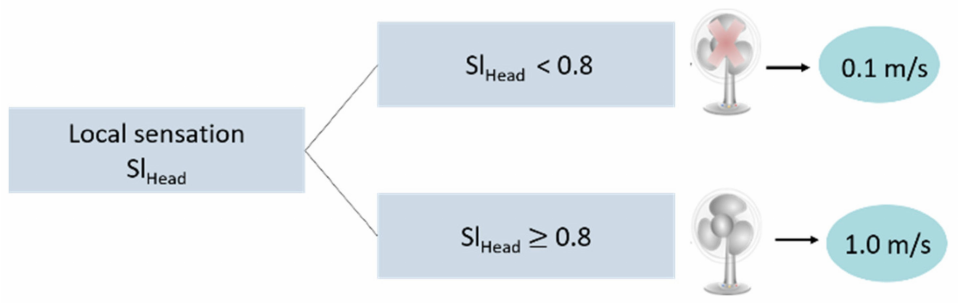
Figure 14. Simplified control logic of the desk fan, which considers the local sensation value of the